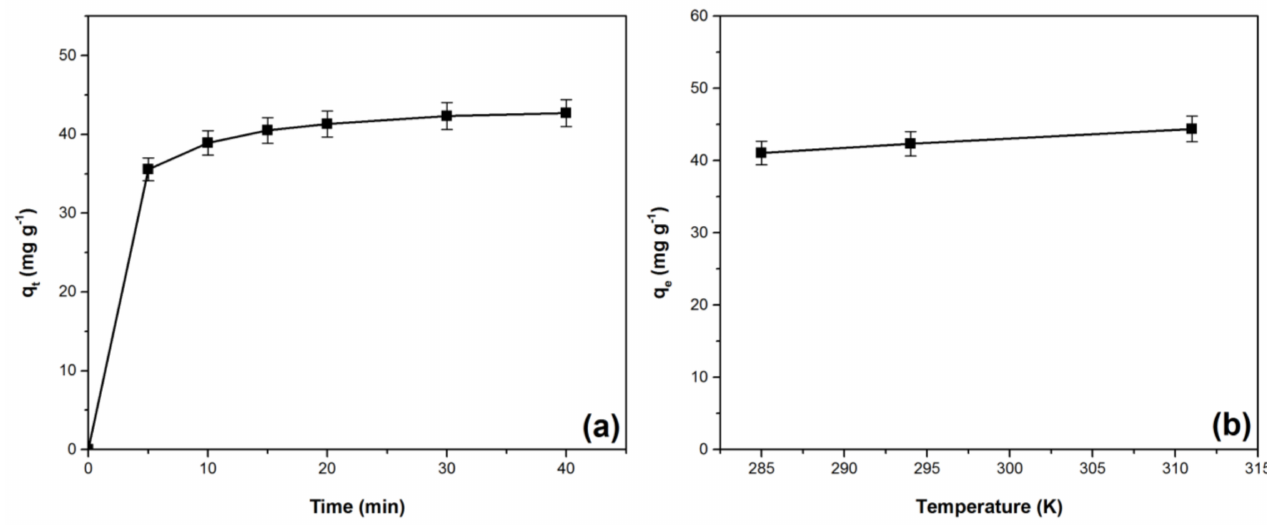
Figure 5. Effect of ( a ) contact time and ( b ) temperature on adsorption capacity for the crystal violet adsorption onto Bathurst burr powder [adsorption conditions: ( a ): pH 7; initial dye concentration: 100 mg · L − 1 ; adsorbent dose: 2 g · L − 1 ; temperature: 294 K, ionic strength: 0 mol L − 1 ( b ): pH 7, initial dye concentration: 100 mg · L − 1 ; contact time: 30 min; adsorbent dose: 2 g · L − 1 ; ionic strength: 0 mol L − 1